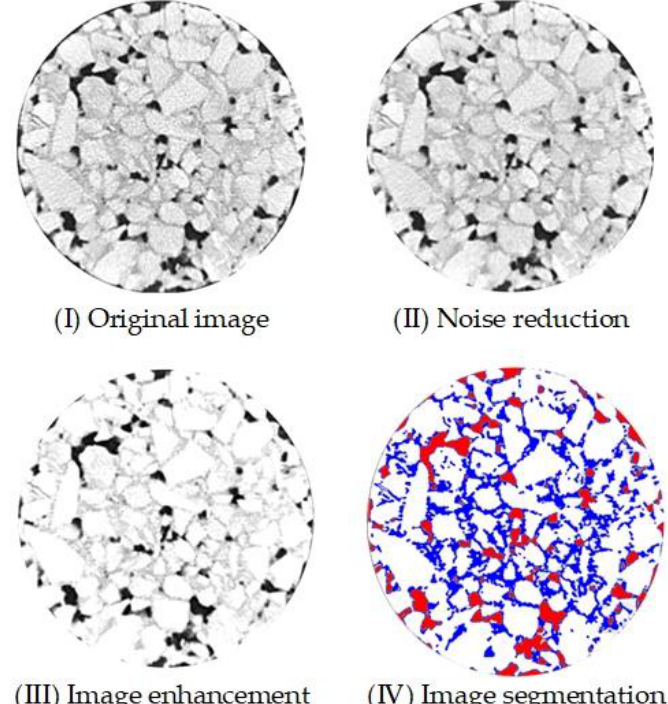
Figure 4. Pre-processing of CT images.